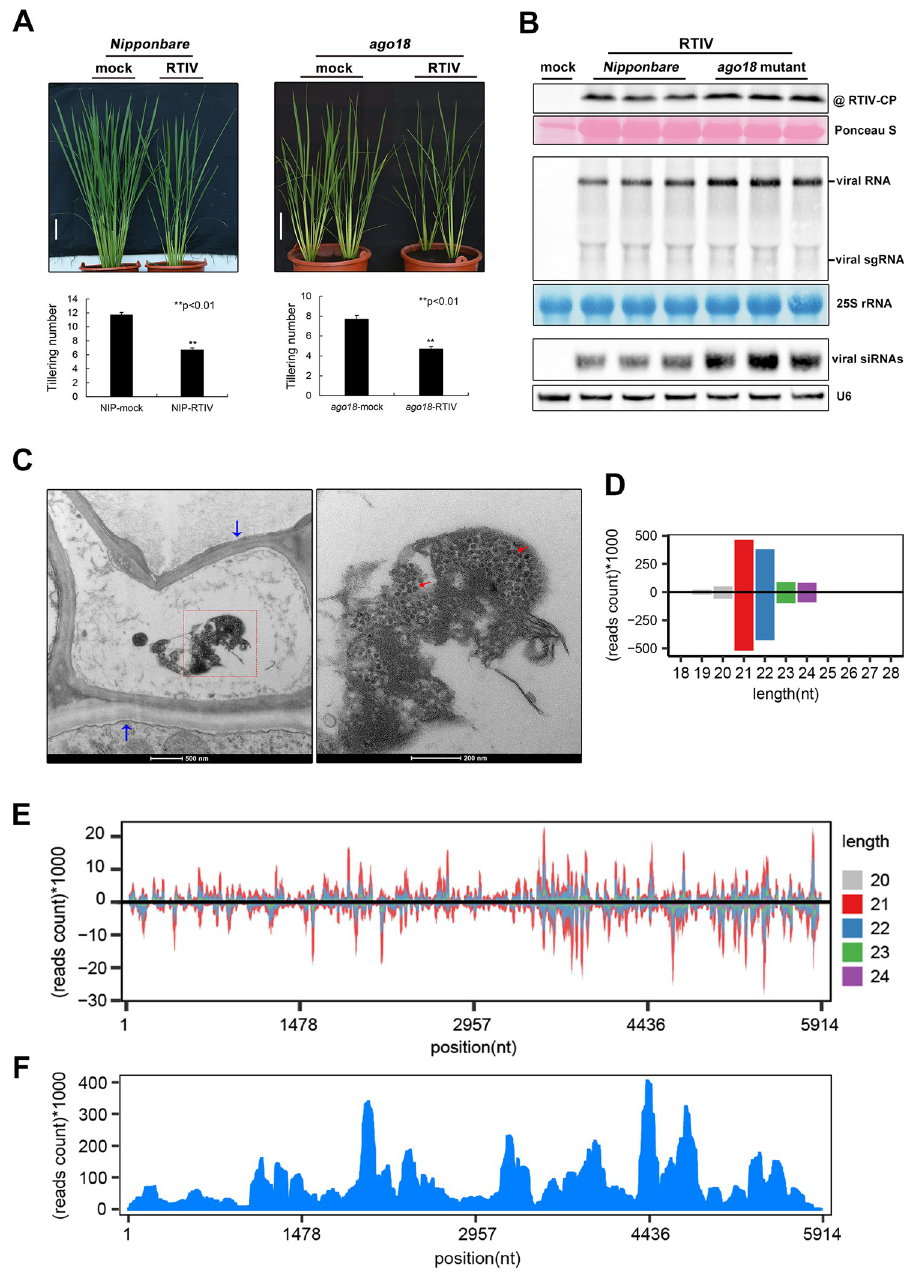
Fig 2. Recovery of RTIV from wild rice and transmission to the domesticated rice by aphid R . padi . (A) The reduced tillering symptom of ago18 plant or NIP plant photographed at ~40dpi. Statistic analysis of tiller number for RTIV-infected ago18 plants or NIP plants compared to mock plants, 25 plants used for each analysis. Scale bars = 10 cm. (B) Detection of RTIV CP by Western blotting (top panel), RTIV genomic/subgenomic (sg) RNAs (middle panel) and RTIV siRNAs (bottom panel) by Northern blotting in Nipponbare and ago18 mutant plants. Loading control was monitored by ponceau staining, 25S rRNA staining or U6 RNA probing in the same membrane. (C) Distribution of RTIV virions within the cell of ago18 mutant plants with a magnified view of the boxed area shown at the right. Viral particles (red arrows) are approximately 30 nm in diameter. Blue arrows show vascular bundle cell wall on the left. (D/ E) Size distribution (D) and the single-nucleotide resolution maps (E) of the positive- and negative-strand RTIV- derived small RNA reads (18–30 nt) sequenced from RTIV-infected ago18 plants after aphid transmission. (F) The RTIV genome maps of RNA-seq reads sequenced from RTIV-infected ago18 plants after aphid transmission.